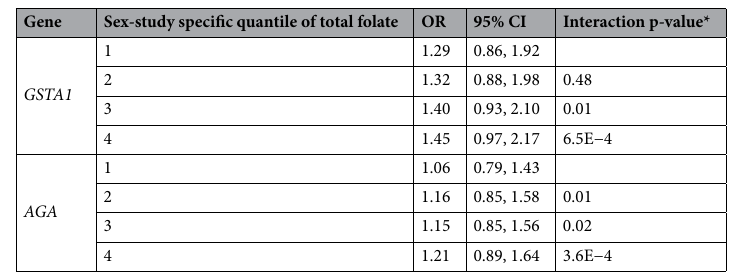
Table 3. Estimated odds ratios (ORs) and 95% confidence intervals (CIs) of colorectal cancer risk per standard deviation change in predicted gene expression stratified by sex-study specific quantiles of total folate consumption. Models were adjusted for age, sex, study, sex-study specific quartiles of total energy consumption in kcal, and principal components to account for population stratification. *p-value tests for difference in quantile specific OR estimate for per standard deviation change in predicted gene expression and the lowest sex-study specific quantile of total folate quantile on colorectal cancer risk.